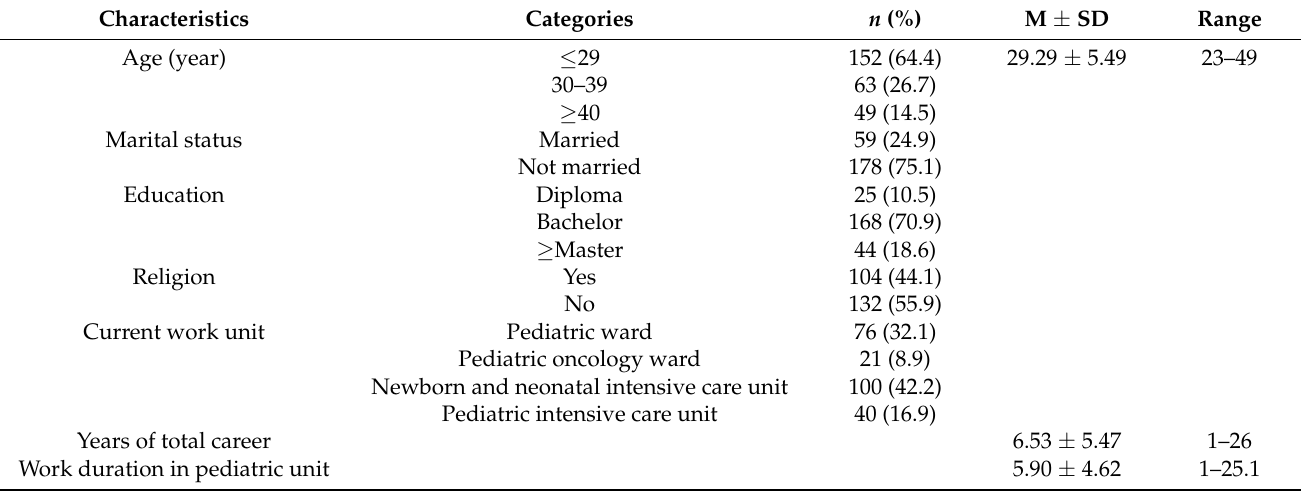
Table 1. Characteristics of Participants ( n =